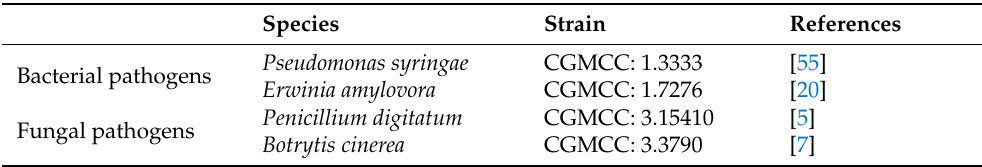
Table 1. Bacterial and fungal pathogens from China General Microbiological Culture Collection Center